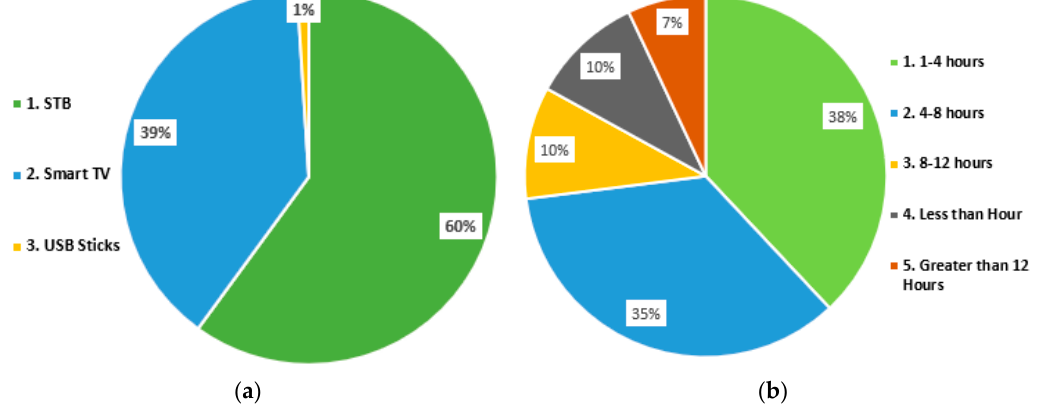
Figure 4. ( a ) Type of smart TVs; ( b ) Time spent in front of a smart TV.